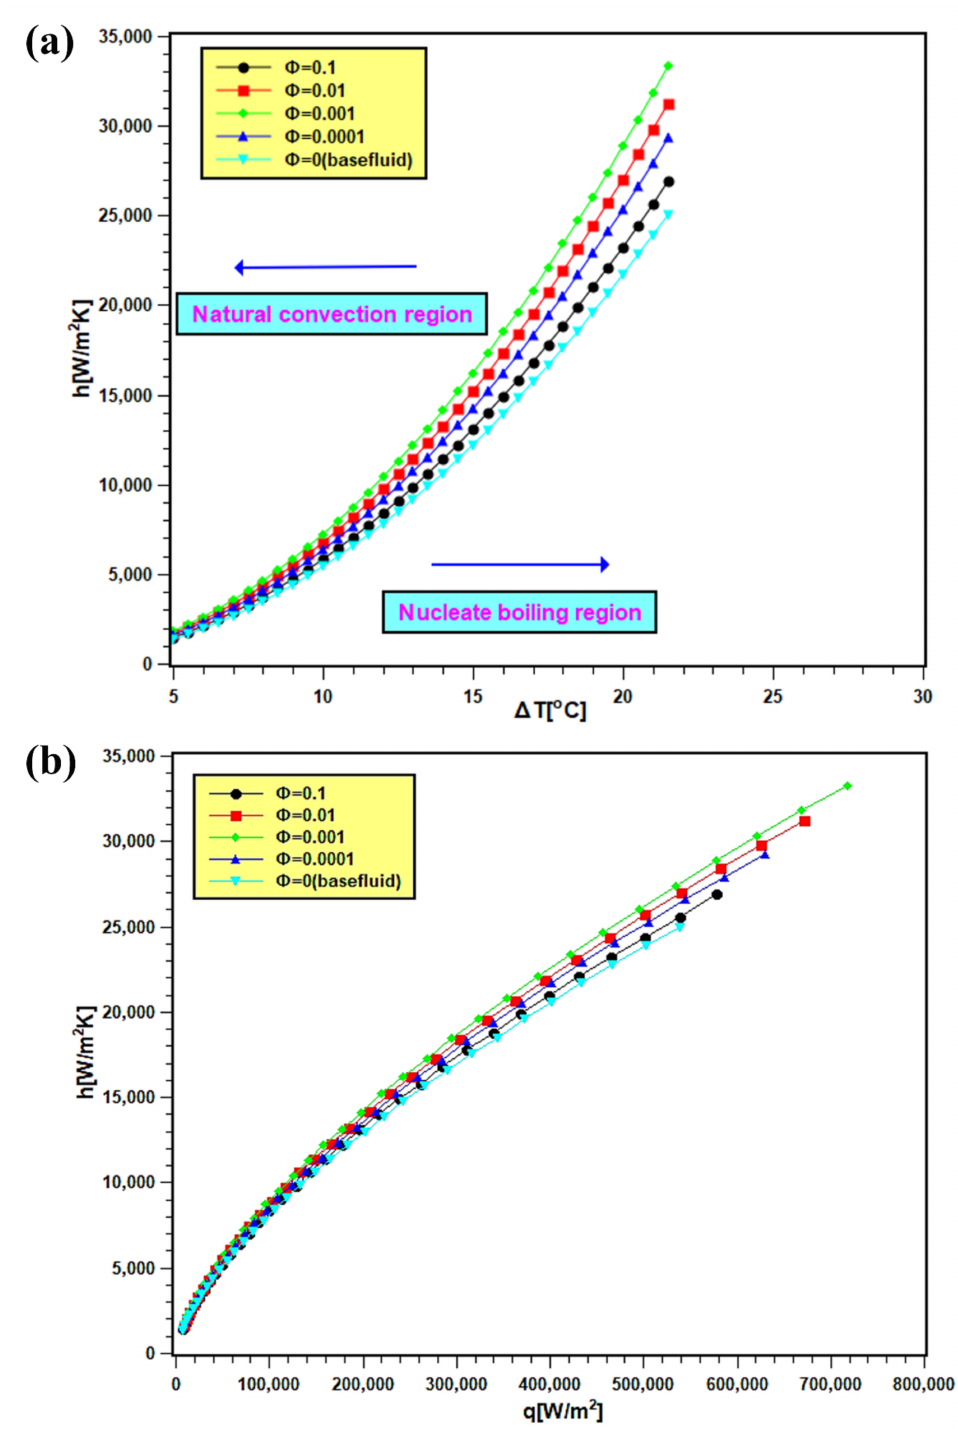
Figure 11. PBHTC of silica nanofluids, where ( a ) is against the wall super heat temperature and ( b ) is against the heat flux at different volume